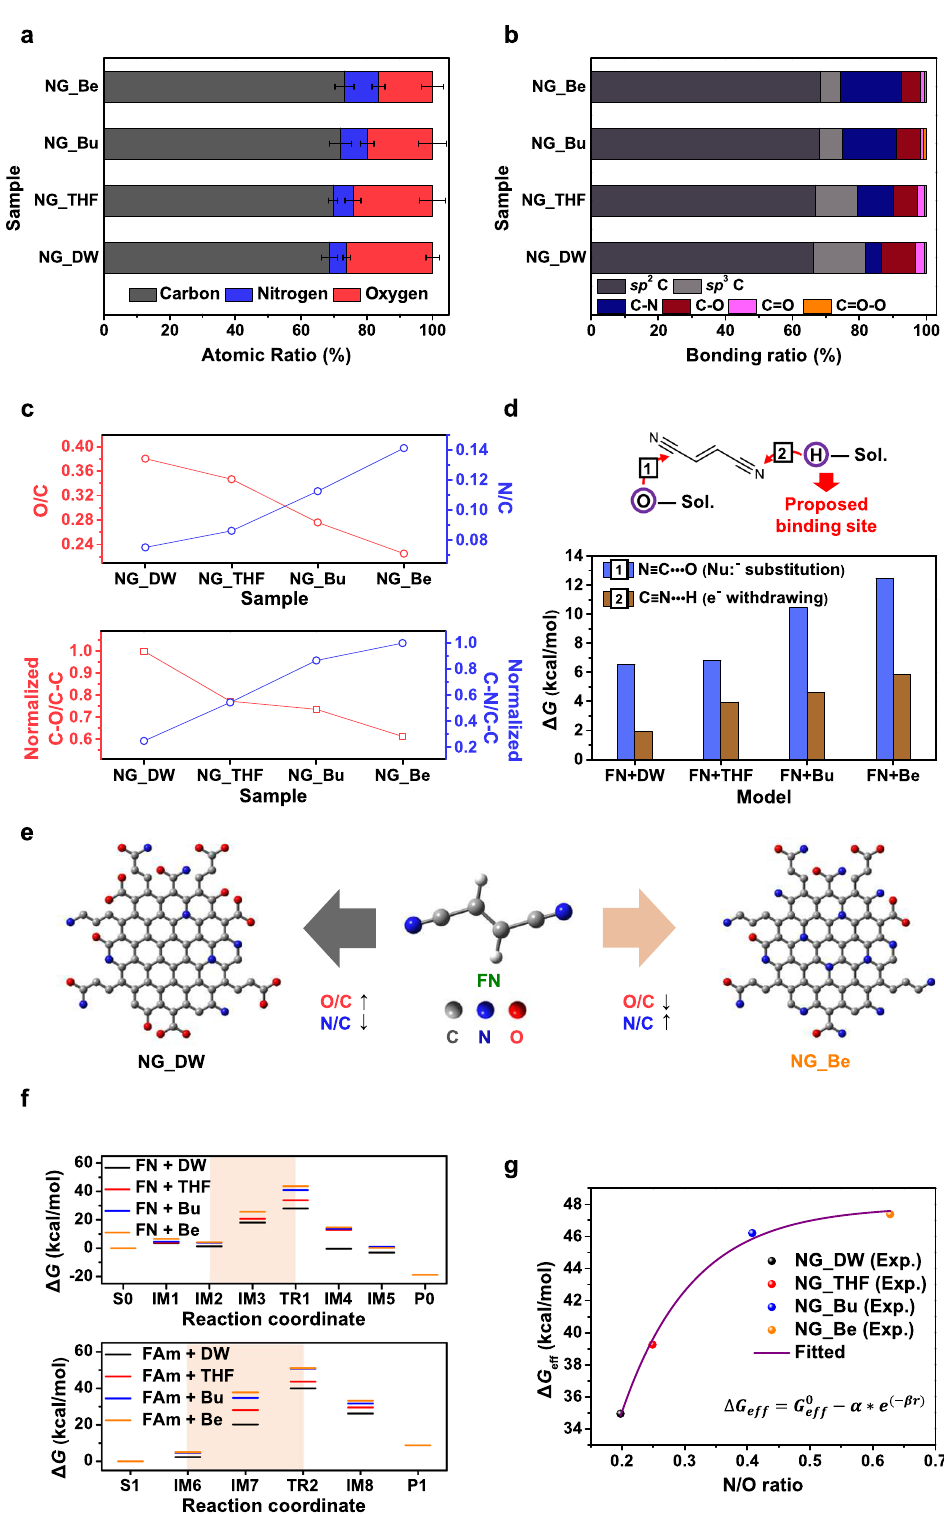
Fig. 2 Chemical composition characterization of NGs. a Elemental analysis from XPS measurements of NGs prepared with different reaction solvents. Error bars represent standard deviations from fi ve independent experiments. b Multiple C-bonding con fi gurations observed in the C 1 s spectra of each NGs. c Relative atomic ratios (O/C and N/C, top) and chemical bonding ratios of NGs (C – N/C – C & C – O/C – C, bottom). d Computationally derived interaction energies between FN and organic solvent molecules. e Plausible chemical structures of NGs prepared from different solvent systems. f Free energy pro fi les for the oxidative activation of FN (top) and FAm (bottom) calculated at the B3LYP/6-311 + G(d) level. g Correlation between the effective Gibbs free energy ( Δ G eff ), obtained from a weighted average of Δ G for selected steps, and the atomic ratio of resulting NGs ( α = 75.6468 kcal/mol, β = 8.8652, G 0 = 47.8776kcal/mol, r = N/O eff